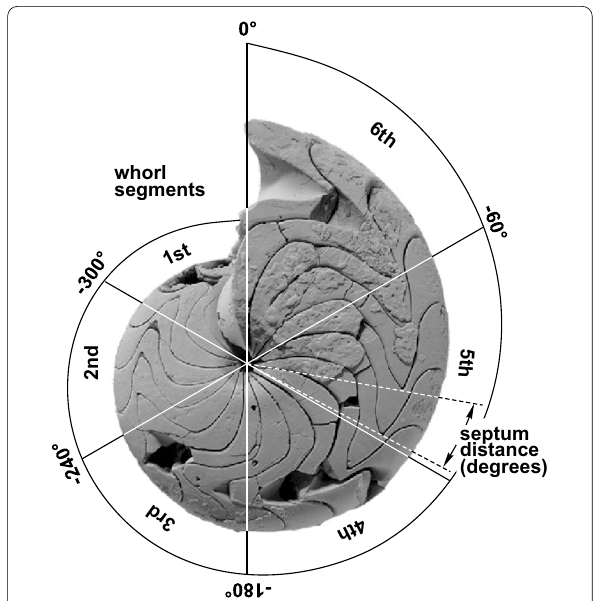
Fig. 3 Measurement of septum distances in the studied ammonoids